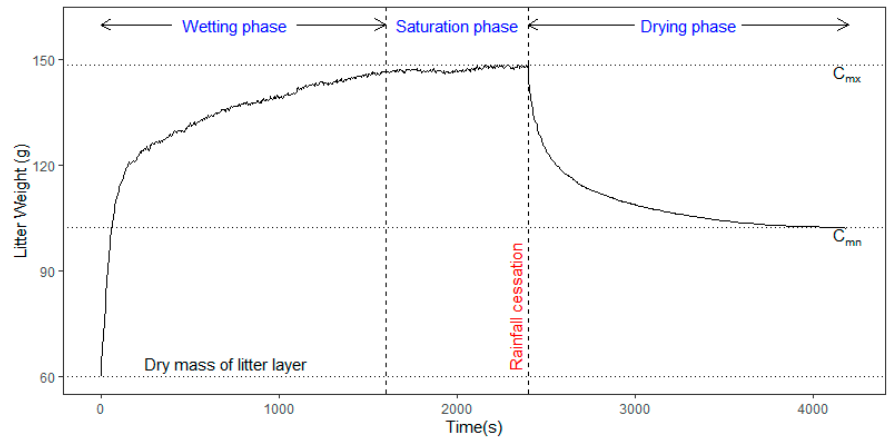
Figure 2. Graphical representation of interception storage capacity in the litter weight curve.